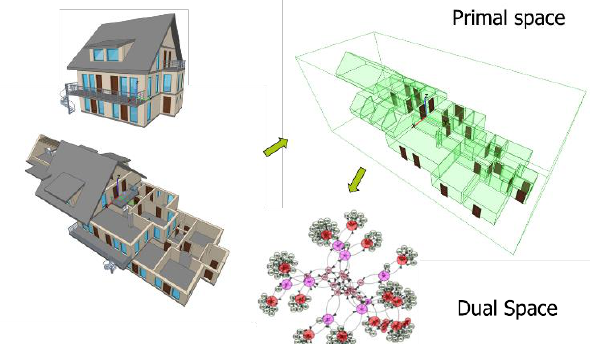
Figure 3: Semantics of the Indoor space in IndoorGML (Lee et al